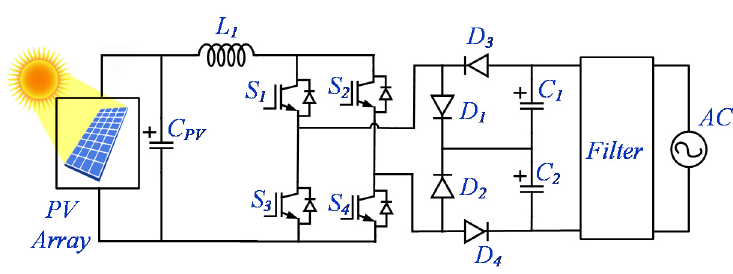
Figure 16. Boost inverter with improved zero crossing.